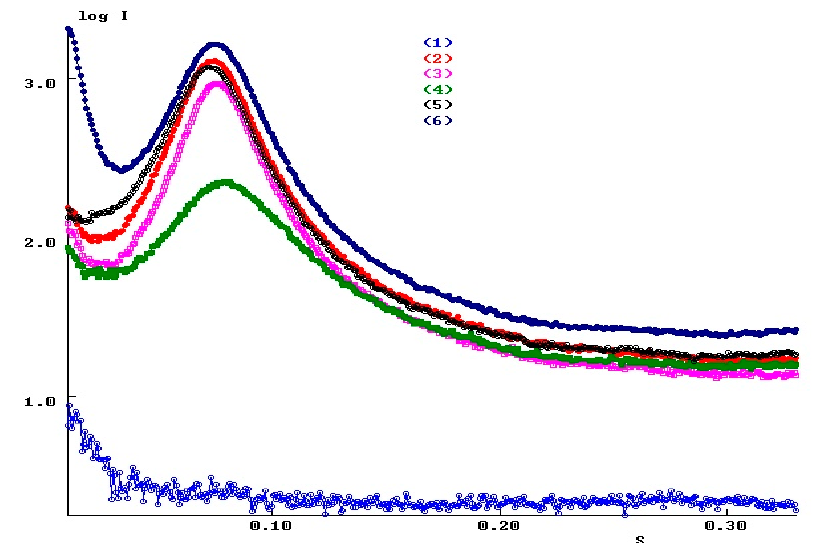
Figure 12. SAXS diffraction intensity profiles at 23 °C (in logarithmic scale): ( 1 ) background scattering ( 2 ), POI-Gl-POSS-0.1 ( 3 ), POI-Gl-POSS-0.5 ( 4 ), POI-Gl-POSS-5 ( 5 ), POI-Gl-POSS-10 ( 6 ), POI-Gl-POSS-15. ( 2 ), POI-Gl-POSS-0.1 ( 3 ), POI-Gl-POSS-0.5 ( 4 ), POI-Gl-POSS-5 ( 5 ), POI-Gl-POSS-10 ( 6 ), POI-Gl-POSS- Scattering vector s = 4 π Sin θ / λ , Å − 1 ; λ = 1.5418Å is the wavelength of the X-ray 15. Scattering vector s = 4 π Sin θ / λ , Å − 1 ; λ = 1.5418 Å is the wavelength of the X-ray beam.